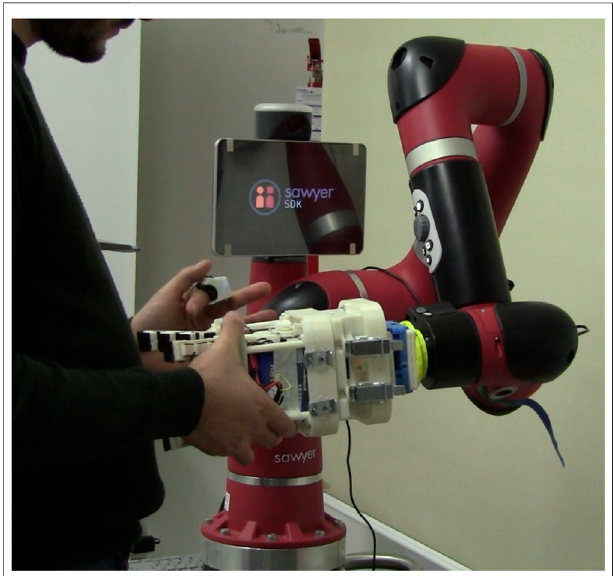
FIGURE 6 | Experimental setup for the user study: the human operator wearsthetactileringandusesthemagnetictoolchangertoattach/detachthe Co-Gripper to/from a collaborative robot arm (Sawyer Robot, Rethink